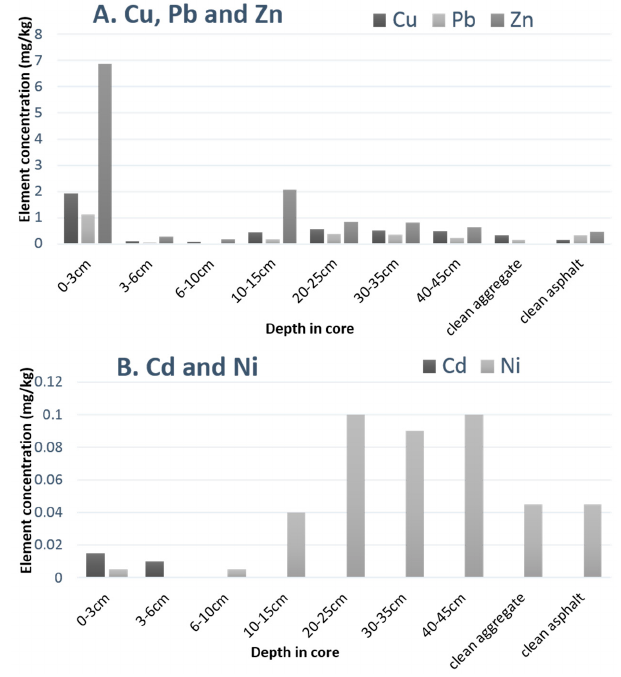
Figure 6. EDTA extractable heavy metals in samples of material taken from various depths within the test rig in comparison with RS, clean aggregate and clean porous asphalt. ( A ) Cu, Pb and Zn; ( B ) Cd and Ni.